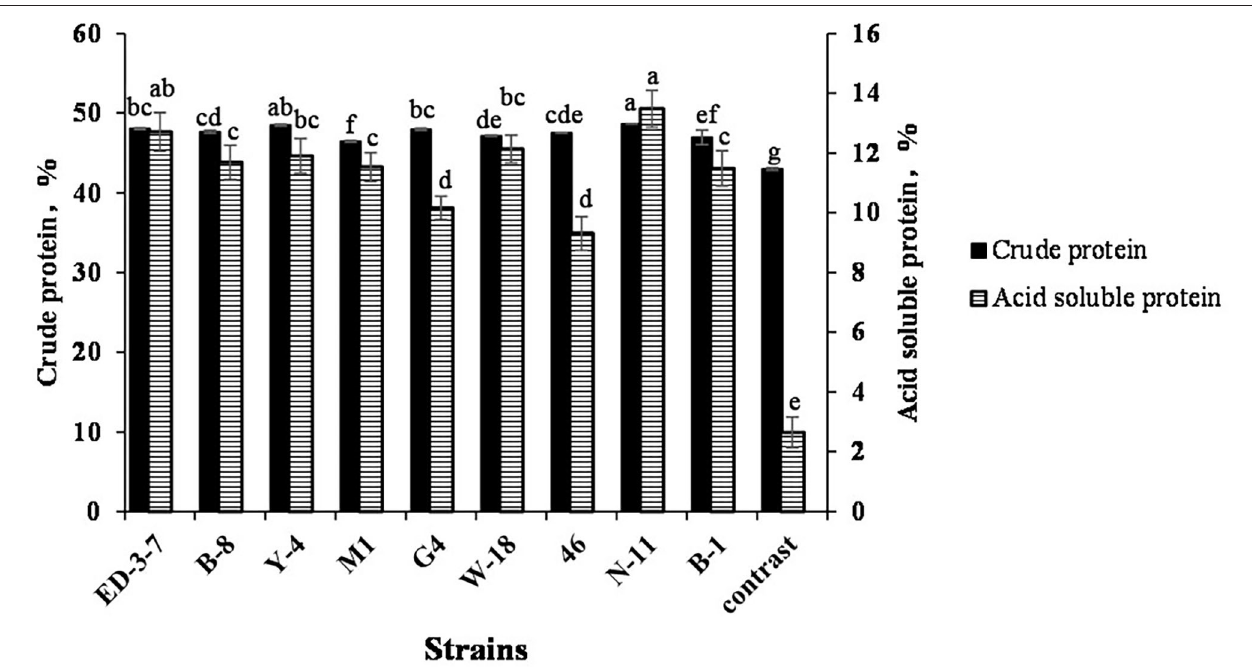
FIGURE 3 | Crude protein and ASP of soybean meal (SBM) and SBM fermented with N-11 (FSBM). Values are expressed as averages ± standard deviation. Different letters indicate significant differences ( P < 0.05) among